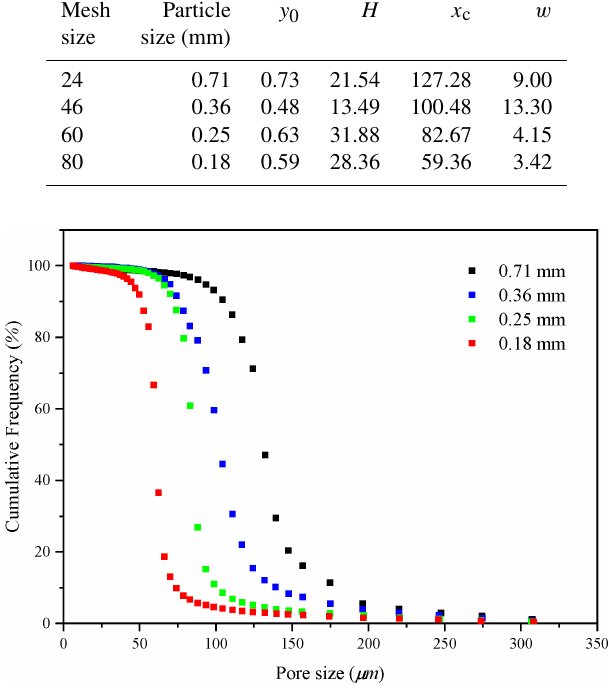
Figure 12. The cumulative frequency curves of the pore size distri-